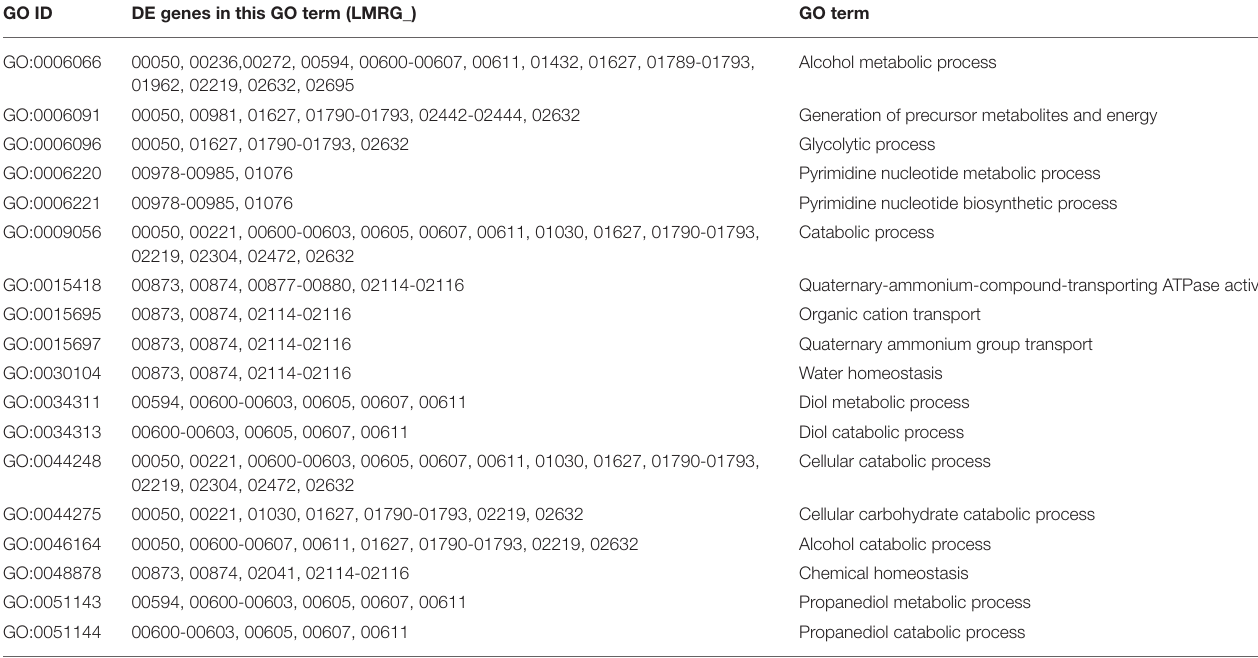
TABLE 3 | Enriched GO terms for 201 genes in 105 σ B -dependent TUs a .